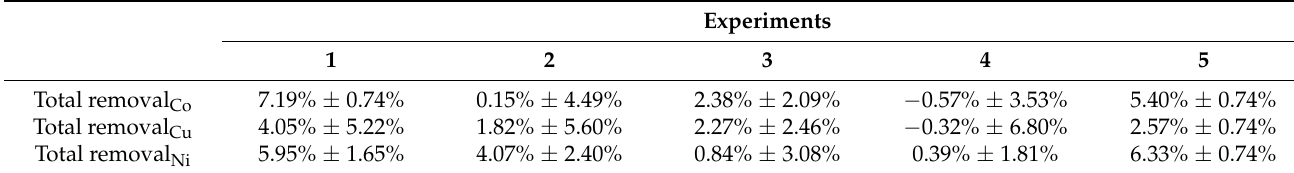
Table 3. Global removal for each metal in every experiment.